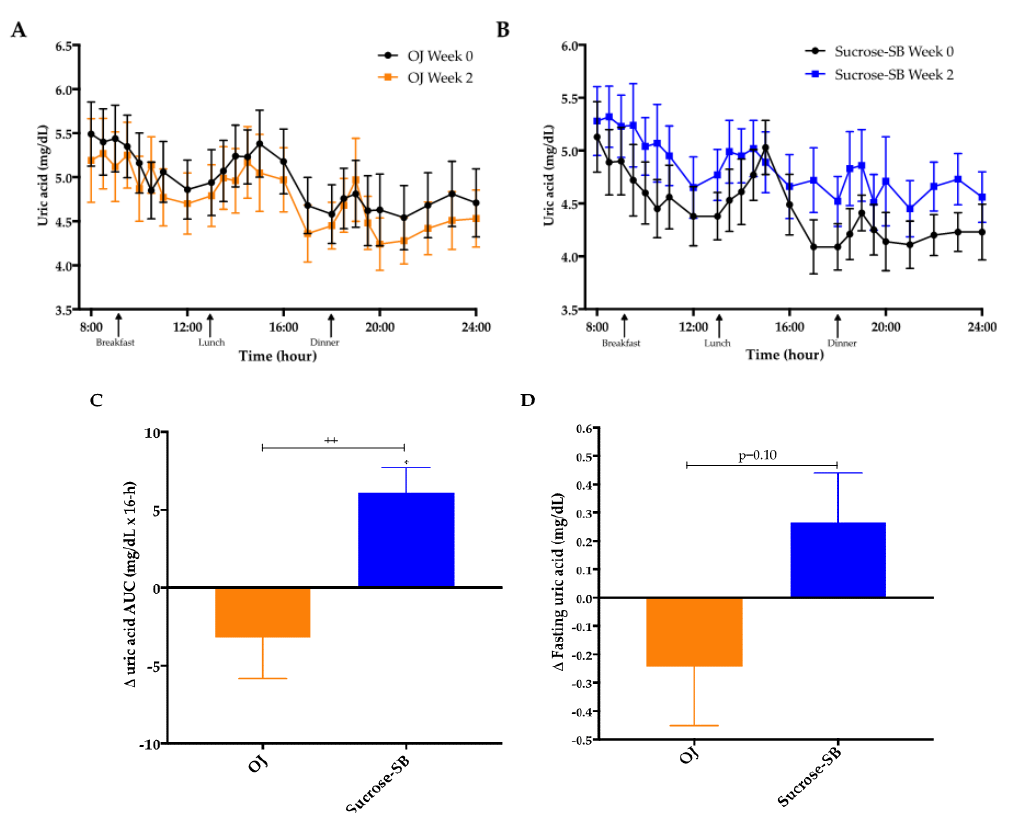
Figure 2. Uric acid concentrations: Sixteen-hour circulating uric acid concentrations before (black line) and after (orange line, orange juice (OJ); blue line, sucrose-sweetened beverage (sucrose-SB) consumption of either ( A ) OJ or ( B ) sucrose-SB for two weeks. Change of 16-h area under the curve (AUC) for ( C ) uric acid and ( D ) fasting uric acid in women consuming either naturally-sweetened OJ (orange bars) or sucrose-SB (blue bars) for two weeks. ++ p < 0.01, effect of group. * p < 0.05, LS mean of change different from zero.